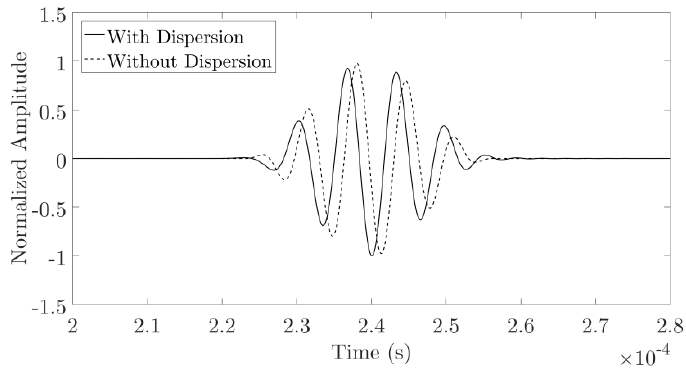
Figure 2. S 0 -mode wavepacket of 5 cycles at 150 kHz after propagating 1.2 m, with dispersion and without